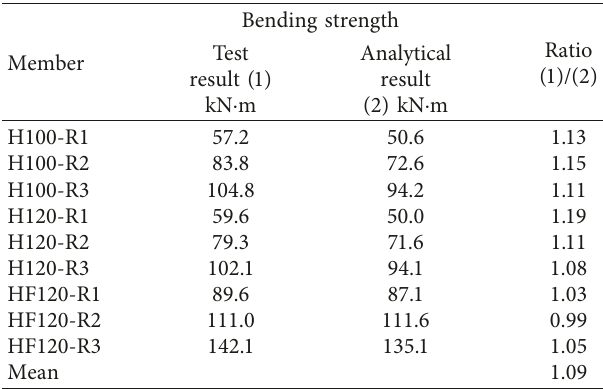
Figure 16: Tensile stress-strain relationship model of rebar. Table 4: Test and analytical